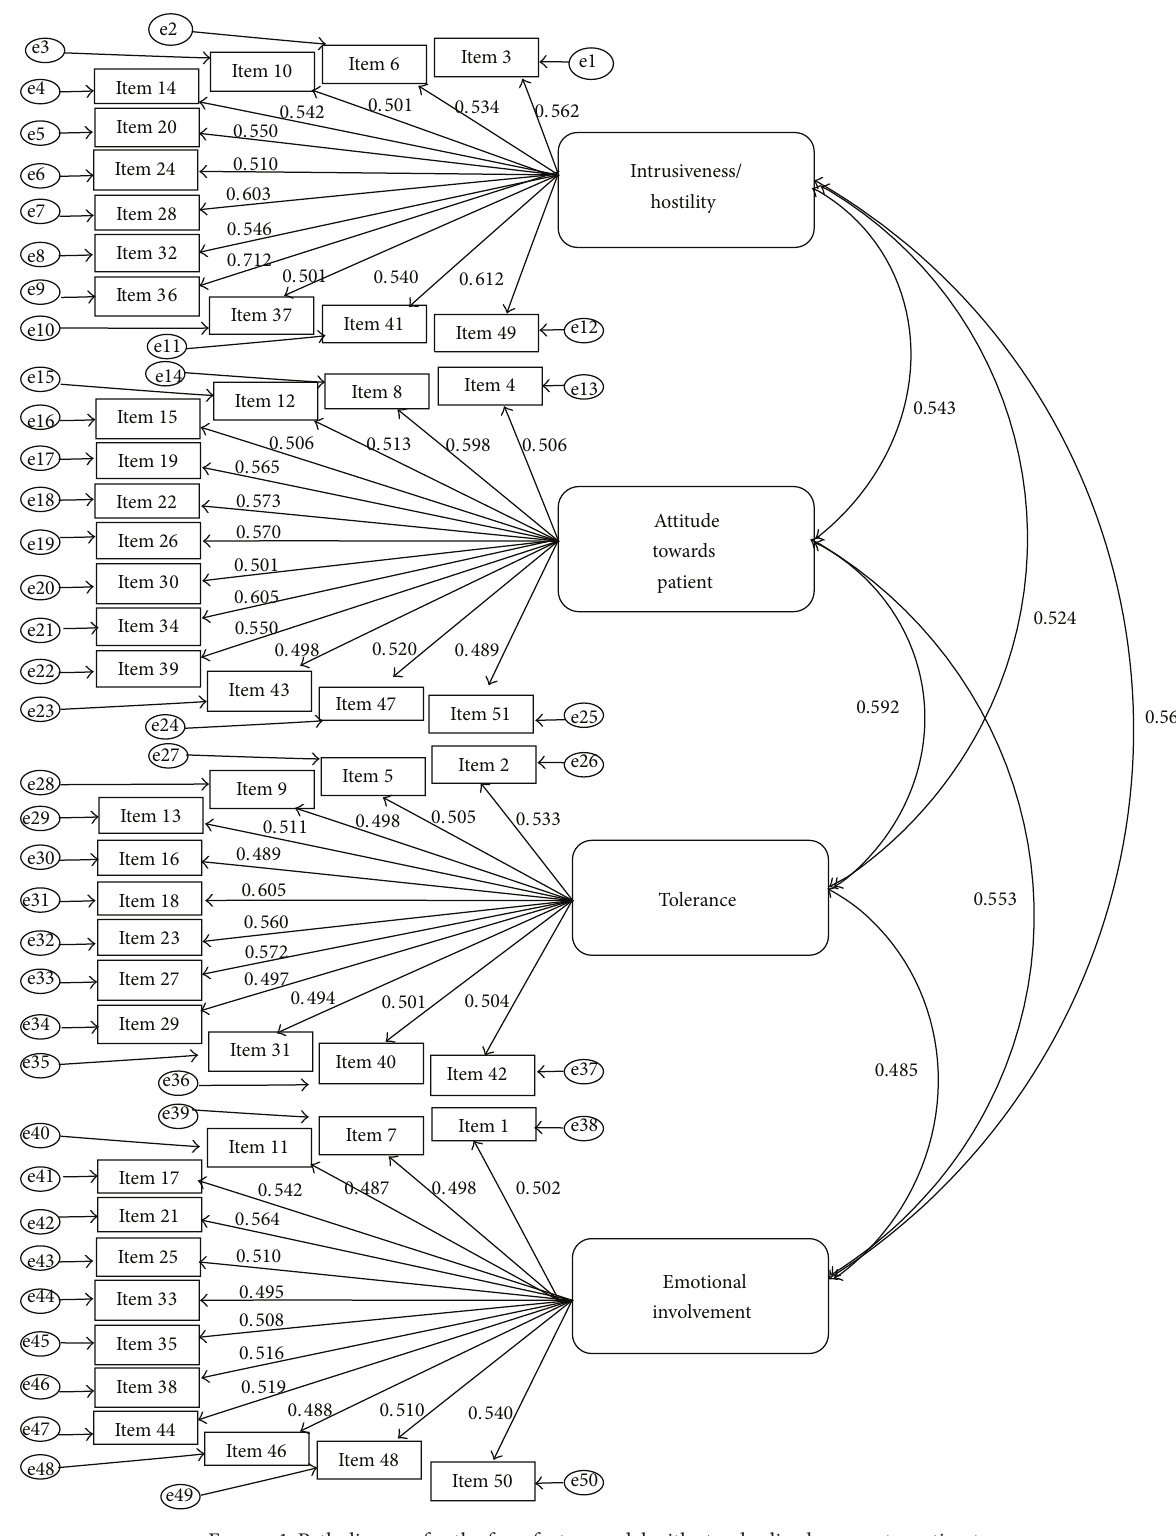
Figure 1: Path diagram for the four-factor model with standardized parameter